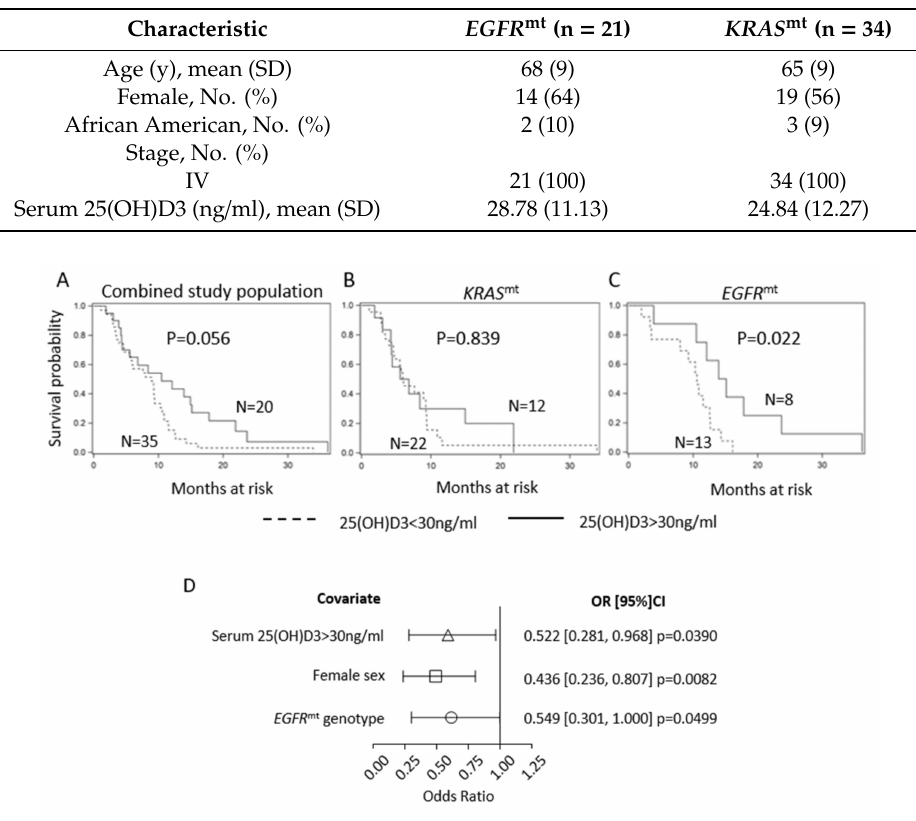
Figure 1. Serum 25(OH)D3 predicts PFS in EGFR -mutant LUAD but not KRAS -mutant LUAD. Participants were divided into groups based on their serum 25(OH)D3 levels with the cut-o ff set at 30 ng / mL. Kaplan–Meier progression-free survival (PFS) analyses in combined EGFR - and KRAS -mutant cohort ( A ), KRAS -mutant ( B ), and EGFR -mutant ( C ) subsets are shown. ( D ) Forest plot of associations between PFS and serum 25(OH)D3 / patient sex / tumor